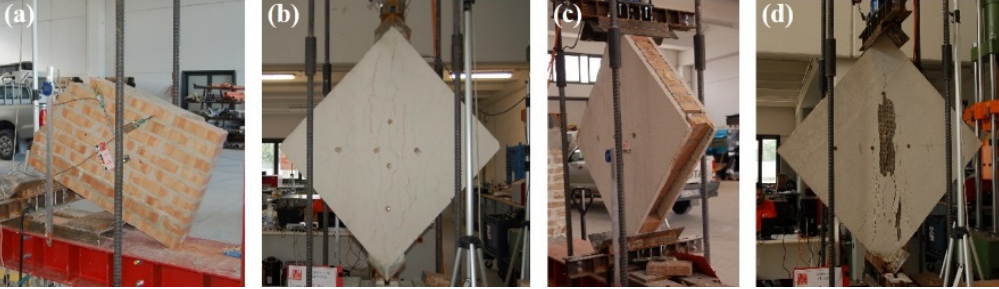
Figure 6. Failure modes observed in ( a ) UM, ( b ) GTRM, ( d ) BTRM and ( c ) GTRM debonding detail.